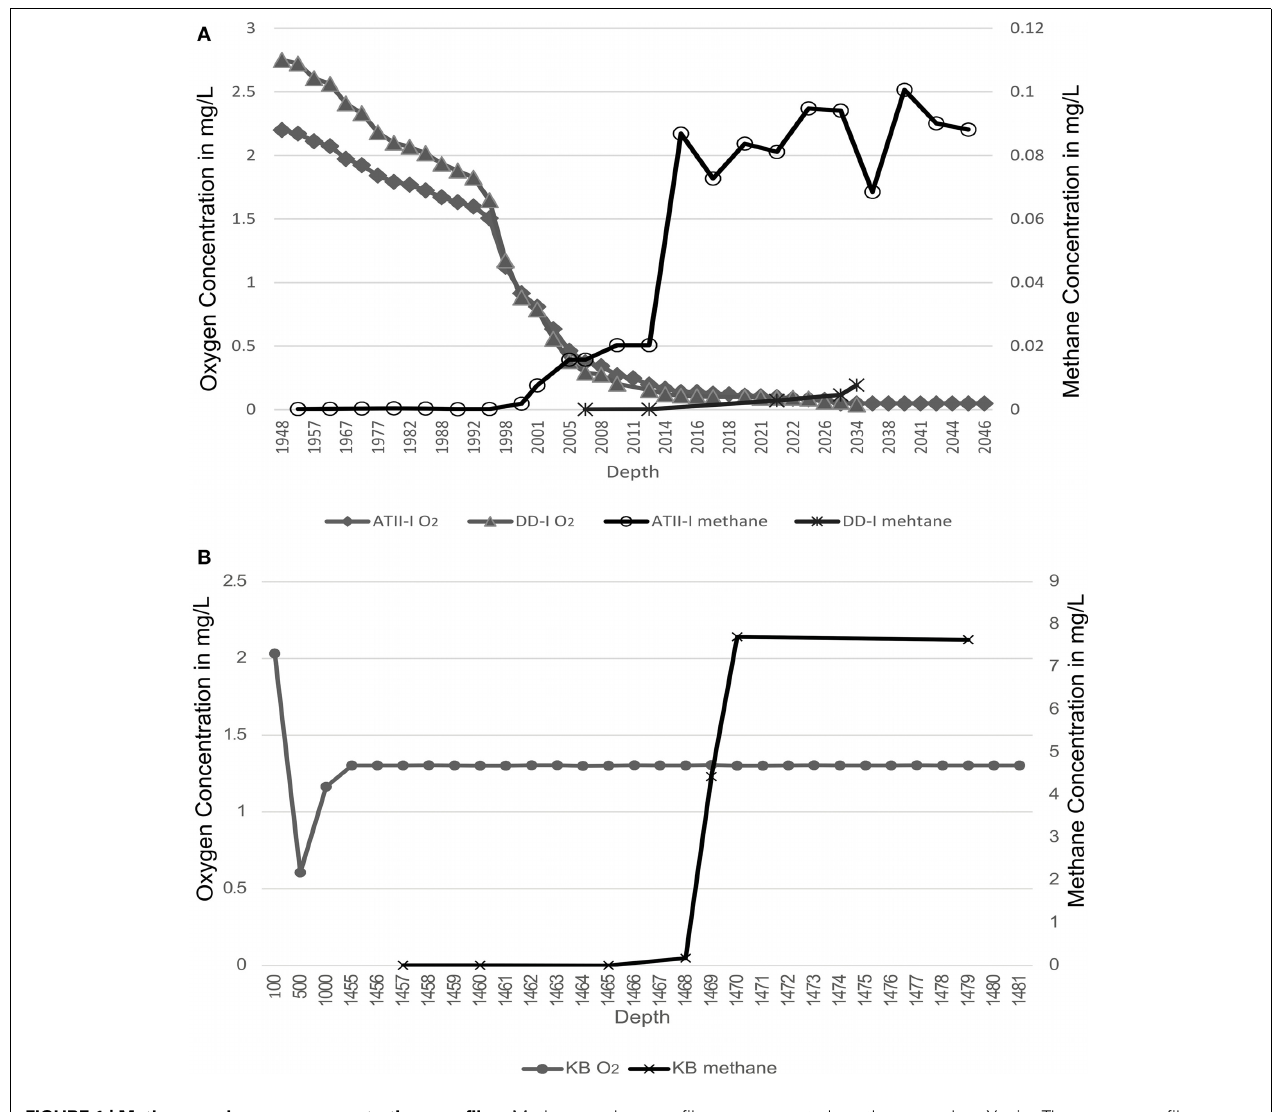
profiles are presented on the secondary Y-axis. The oxygen profiles are based on CTD measurements conducted during sampling in the present study, while the methane profiles are based on measurements from Schmidt et al.